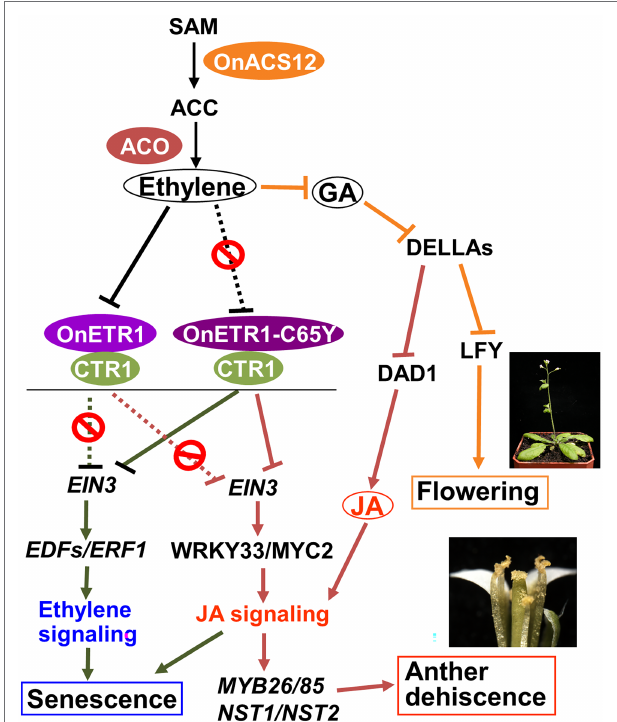
FIGURE 8 | Model for the function of OnACS12 and OnETR1 - C65Y in regulating ethylene, GA-DELLA and JA signaling in Arabidopsis . The ectopic expression of Oncidium OnACS12 delayed flowering and produced indehiscent anthers in Arabidopsis through an increase ( ) in ACC and ethylene production, which influenced GA–DELLA signaling by suppressing ( ) GA production and activating DELLA activity. The increased DELLA activity sequentially suppressed ( ) the expression of the flowering time gene LFY and caused late flowering phenotypes. The increased DELLA activity also suppressed ( ) the expression of the JA biosynthesis gene DAD1 , which caused a decrease in JA activity, the suppression of MYB26 , NST1/2 , and MYB85 expression and the failure of secondary thickening in the endothecium, resulting in the production of indehiscent anthers. In wild-type plants, Oncidium OnETR1 can bind to and be suppressed ( ) by ethylene, resulting in the inability ( ) to activate CTR1 to ( ) suppress positive regulators (i.e., EIN3 ) and downstream genes ( EDFs and ERF1 ) of the ethylene response, as well as the downstream JA signaling genes MYC2 and WRKY33 . This caused a normal ethylene and JA response and led to leaf/flower senescence and anther dehiscence, respectively. The ectopic expression of OnETR1-C65Y blocked ( ) normal ethylene binding and sequentially activated CTR1 to suppress ( ) the positive regulators (i.e., EIN3 ) and downstream genes ( EDFs and ERF1 ) of the ethylene response, as well as the downstream JA signaling genes MYC2 and WRKY33 , resulting in delayed leaf/flower senescence and indehiscent anthers in Arabidopsis